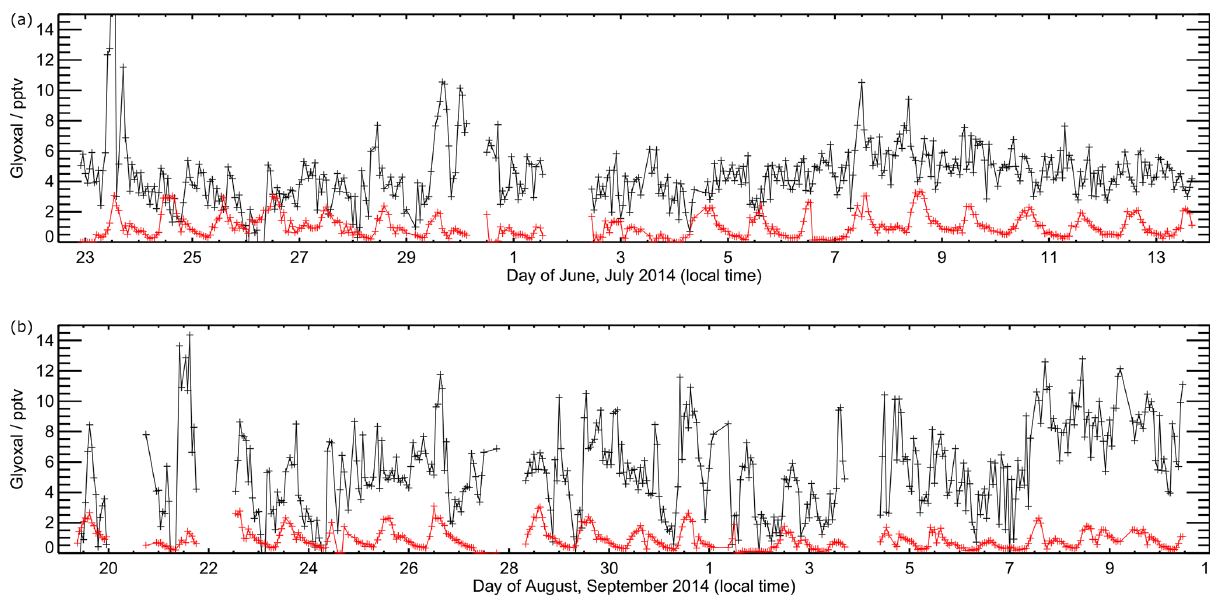
Figure 7. Time series of observed (black) and modelled (red) glyoxal during ORC 3 . Data are shown for model output every 60min. Panel (a) shows data from the first measurement campaign (Julian days 173 to 195), with panel (b) showing data from the second measurement campaign (Julian days 230 to 255).